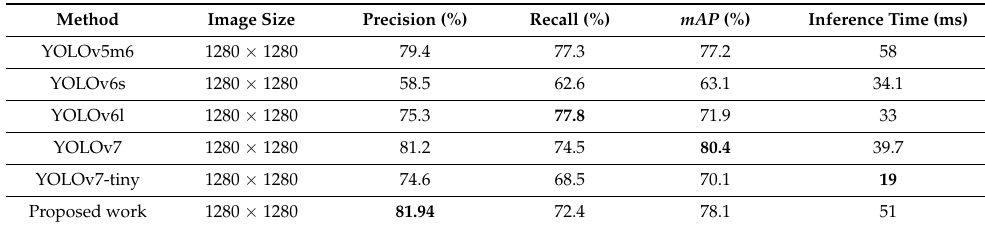
Table 5. Accuracy comparison between YOLO series and proposed